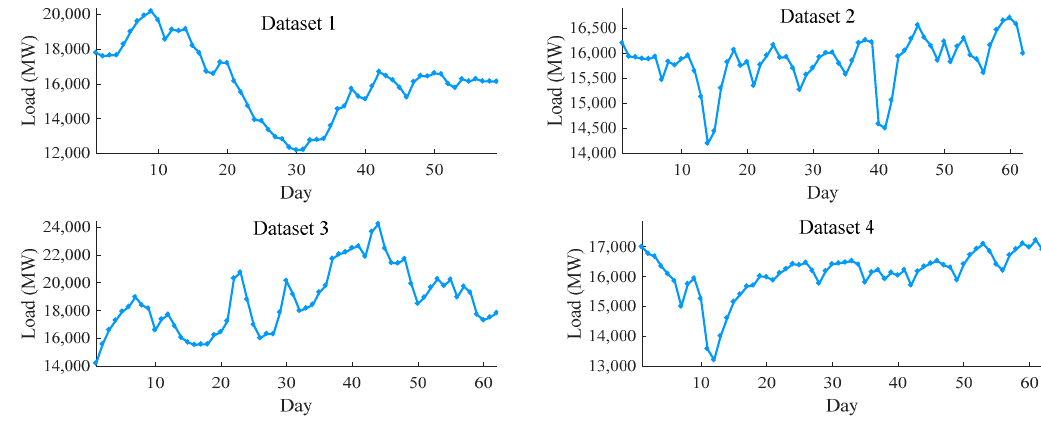
Figure 5. The daily average load for four datasets.